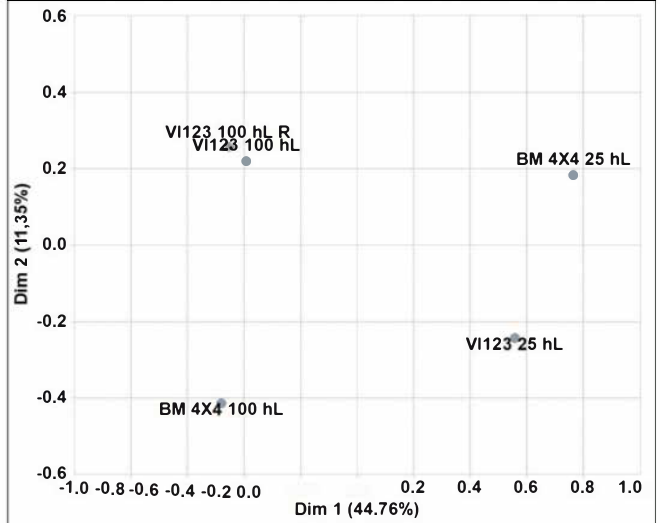
Figure 9. Generalized Procastic Analysis carried out on 30 individual maps of the Napping test performed on wines obtained inoculating the indigenous strain VI 123 and the commercial strain BM4 × 4 in 25 or 100 hL of grape must. (R =